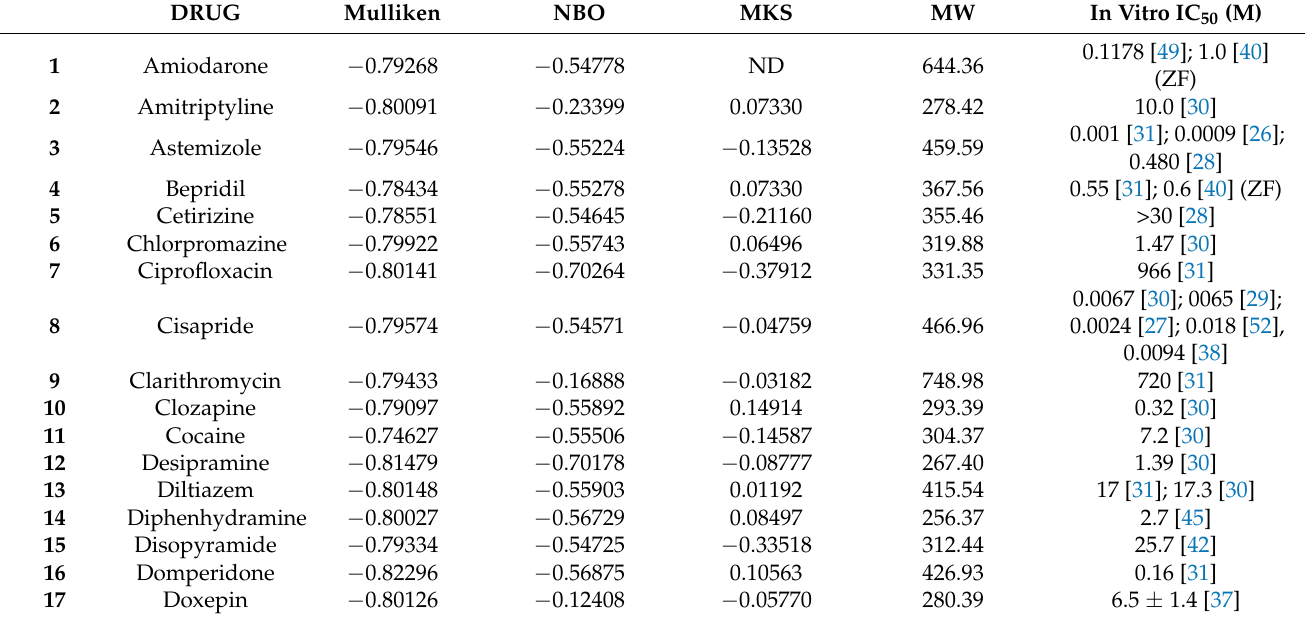
Table 2. Computational analysis using ab initio HF/321G, Mulliken, NBO, and MKS of protonated